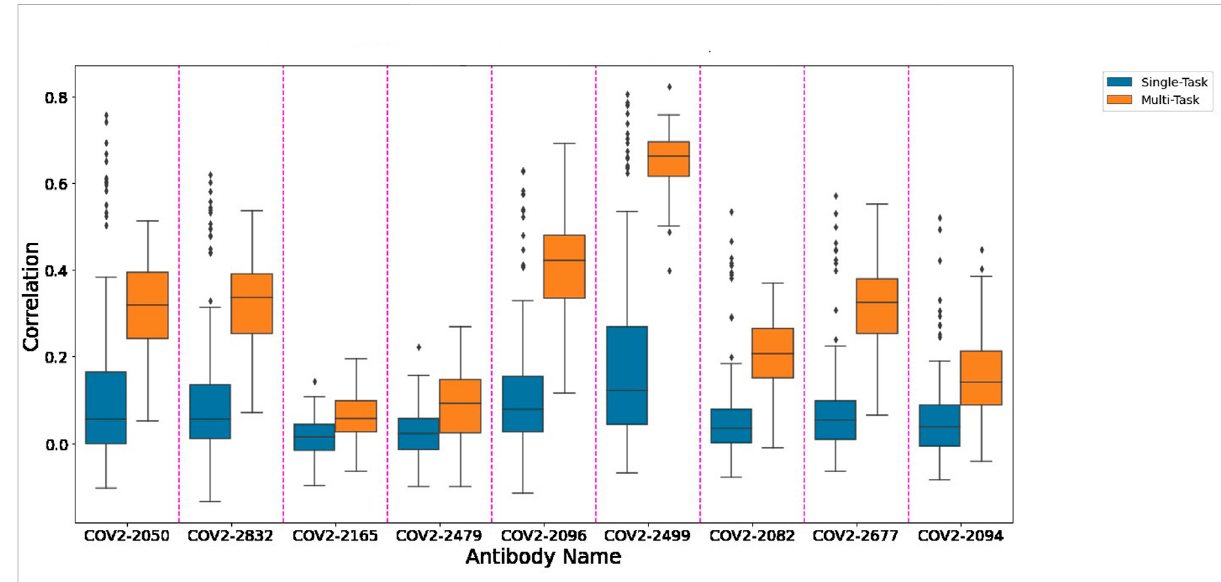
FIGURE 1 A comparison of single-task and multi-task performance in predicting escape probability.